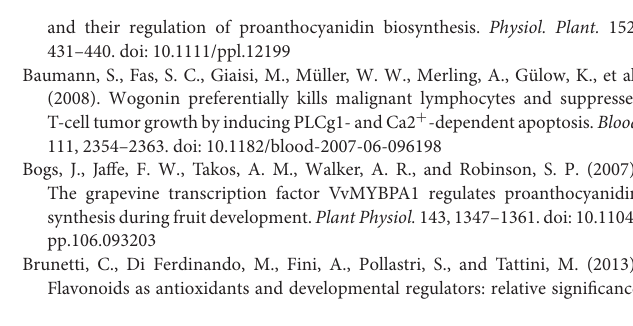
Supplementary Figure 1 | The heatmap analysis of all differentially accumulated metabolites among the flowers of SbW, SbPR, and SbP. The color scale on the right represents the expression degree of differentially accumulated flavonoid metabolites in the material. Red represents high accumulation level and blue represents low accumulation level. Supplementary Figure 2 | The heatmap analysis of all differentially accumulated anthocyanins among the flowers of SbW, SbPR, and SbP according to the relative content in samples. The color scale on the right represents the expression degree of differentially accumulated anthocyanin metabolites in the material. Red represents high accumulation level and blue represents low accumulation level. Supplementary Figure 3 | Number of differentially accumulated anthocyanins among SbPR vs SbP, SbW vs SbP, and SbW vs